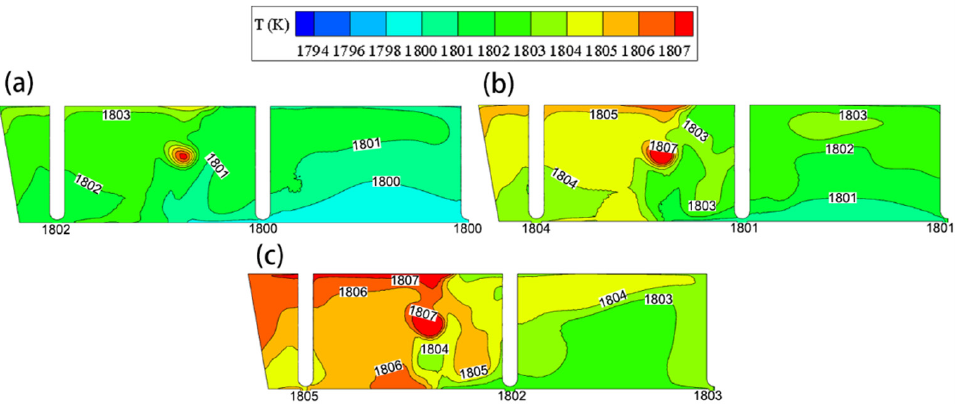
Figure 23. Temperature field of the plane passing through all outlet center for case FK-A0 under different heating power: ( a ) 800 kW; ( b ) 1000 kW; ( c ) 1200 kW.